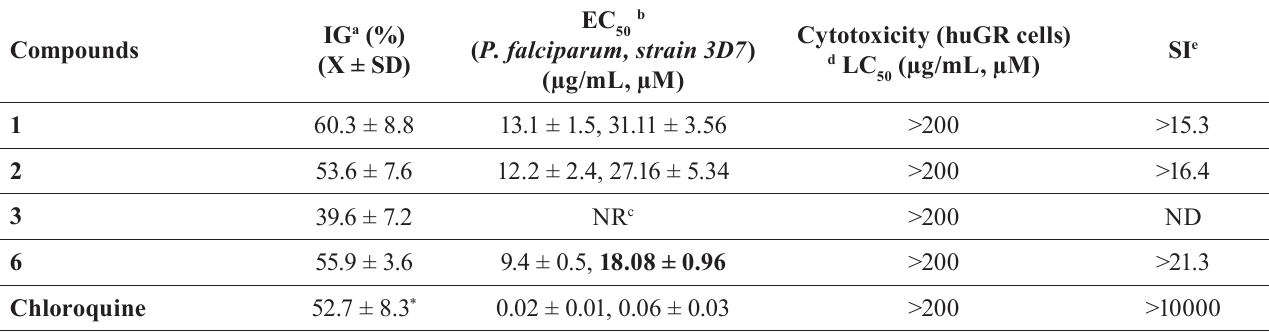
TABLE II - In vitro Anti-plasmodial and Cytotoxicity activity of S -allylcysteine ester-caffeic acid amide conjugates